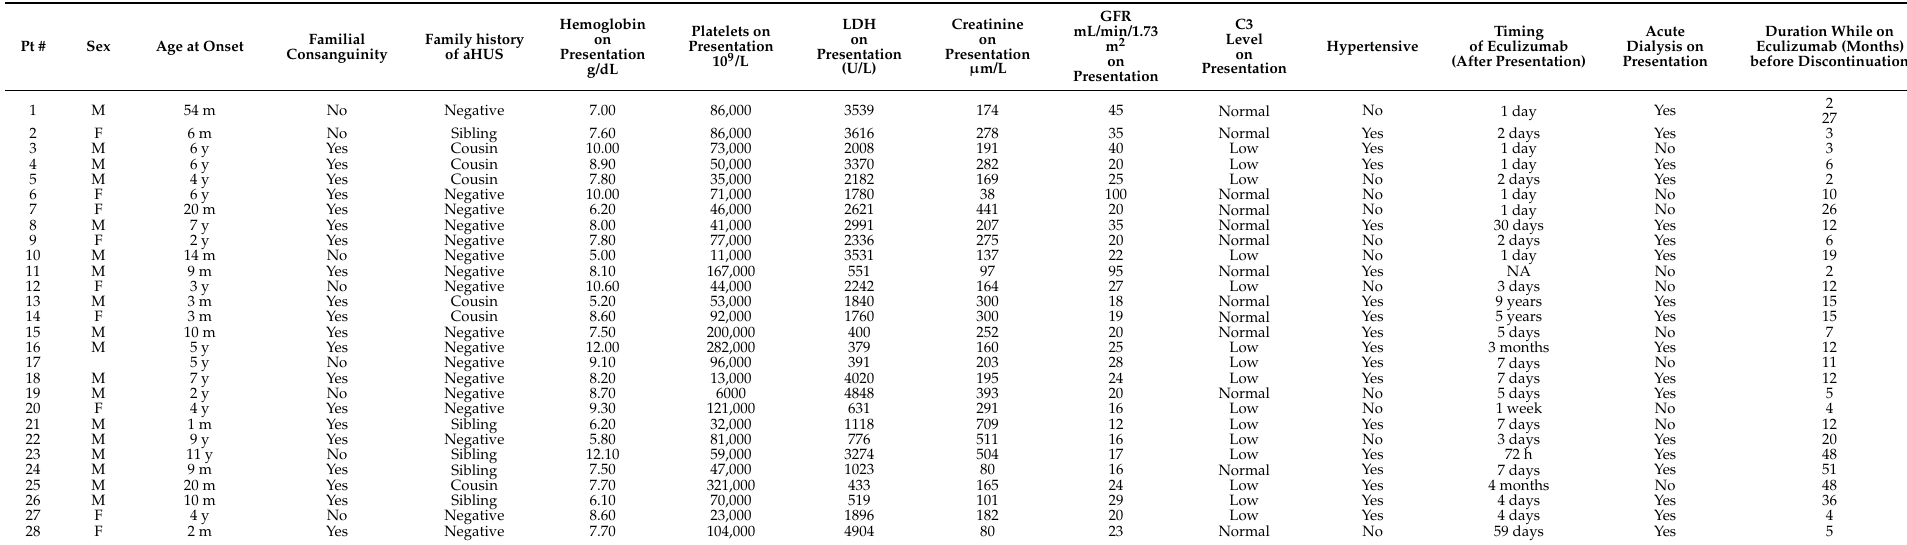
Table 1. Summary of the baseline general characteristics of the patients and laboratory tests at the first presentation of the